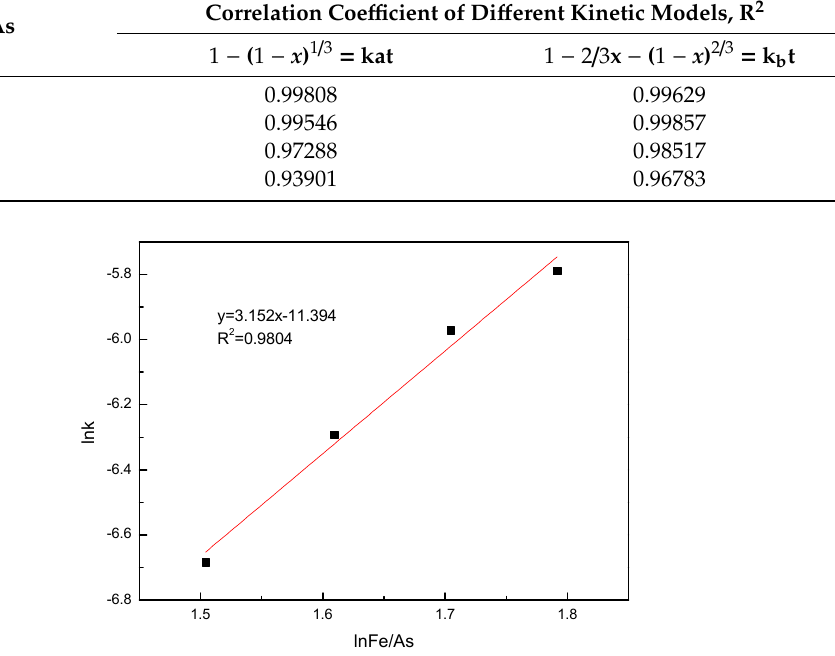
Figure 9. Plot of lnk vs. ln(Fe/As) for the determination of reaction order. The fitting curve of 1 − 2/3x − ( 1 − x ) 2/3 vs. time was obtained at di ff erent CuSO